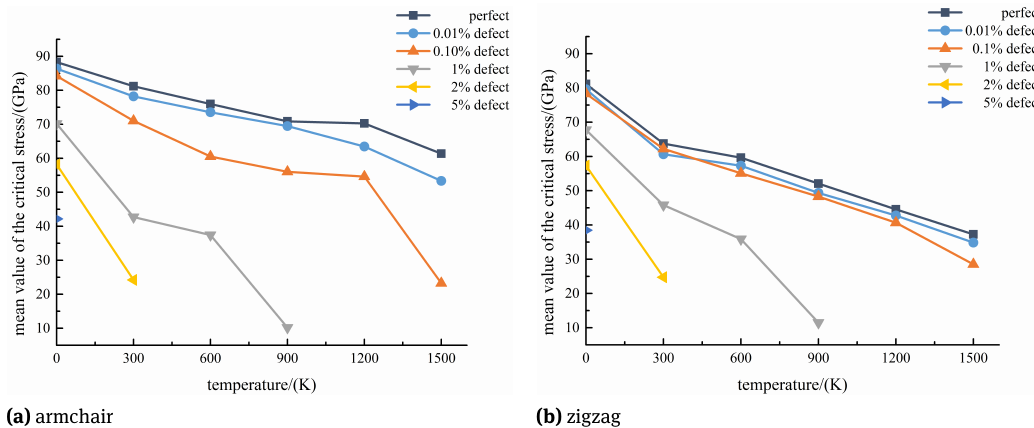
Figure 8: Mean fracture stress as a function of temperature with different percentage of vacancy defect.